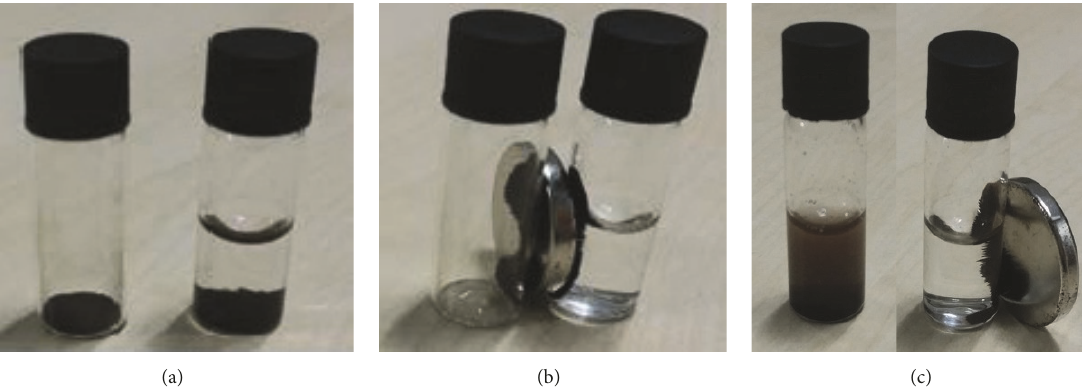
Figure 1: The zirconium-based ferromagnetic sorbent (a) under presence (wet) and absence (dry) of aqueous solution, (b) its magnetic responses under normal condition when being in contact with a permanent magnet, and (c) magnetic separation after sorption